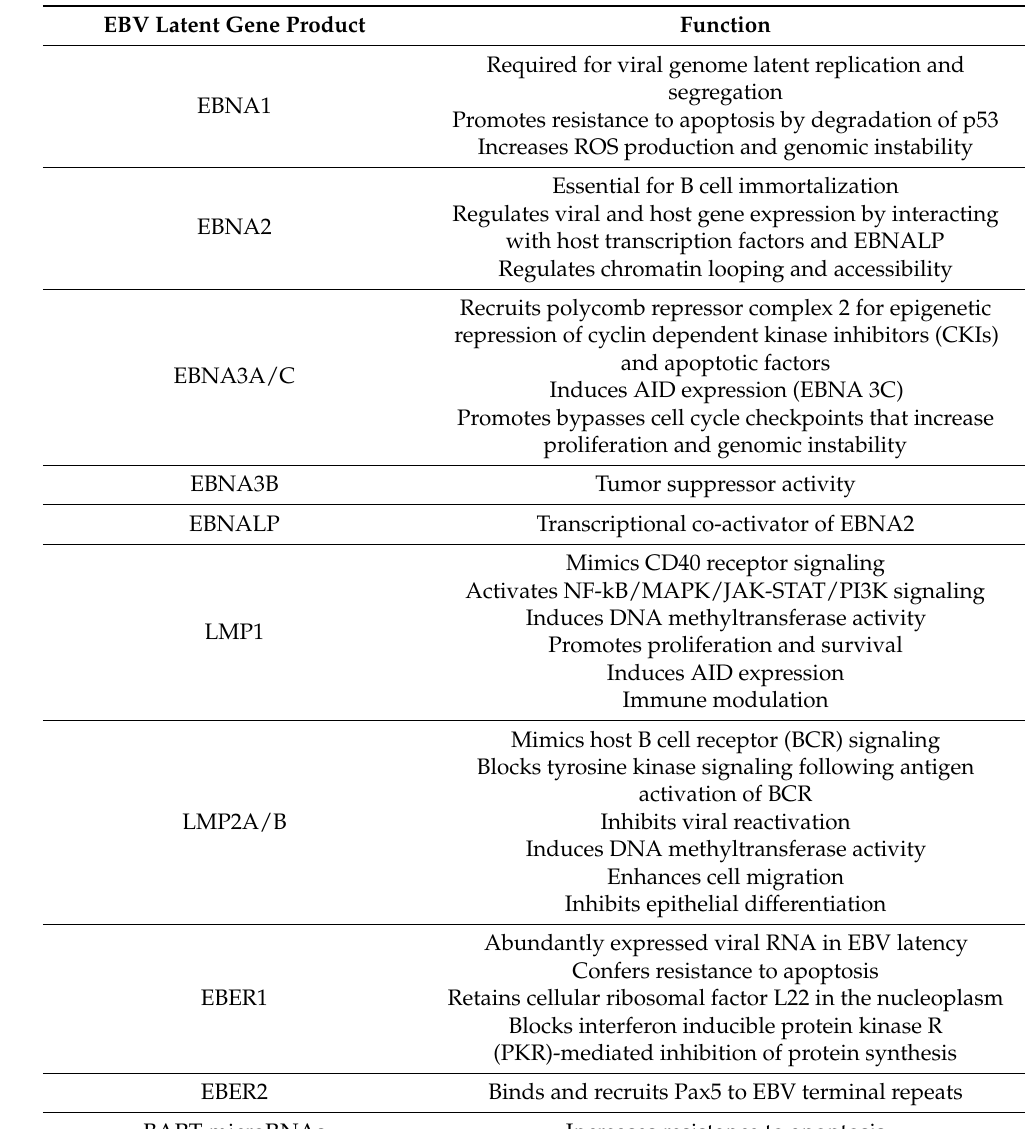
Table 2. Overview of functions encoded by EBV latent